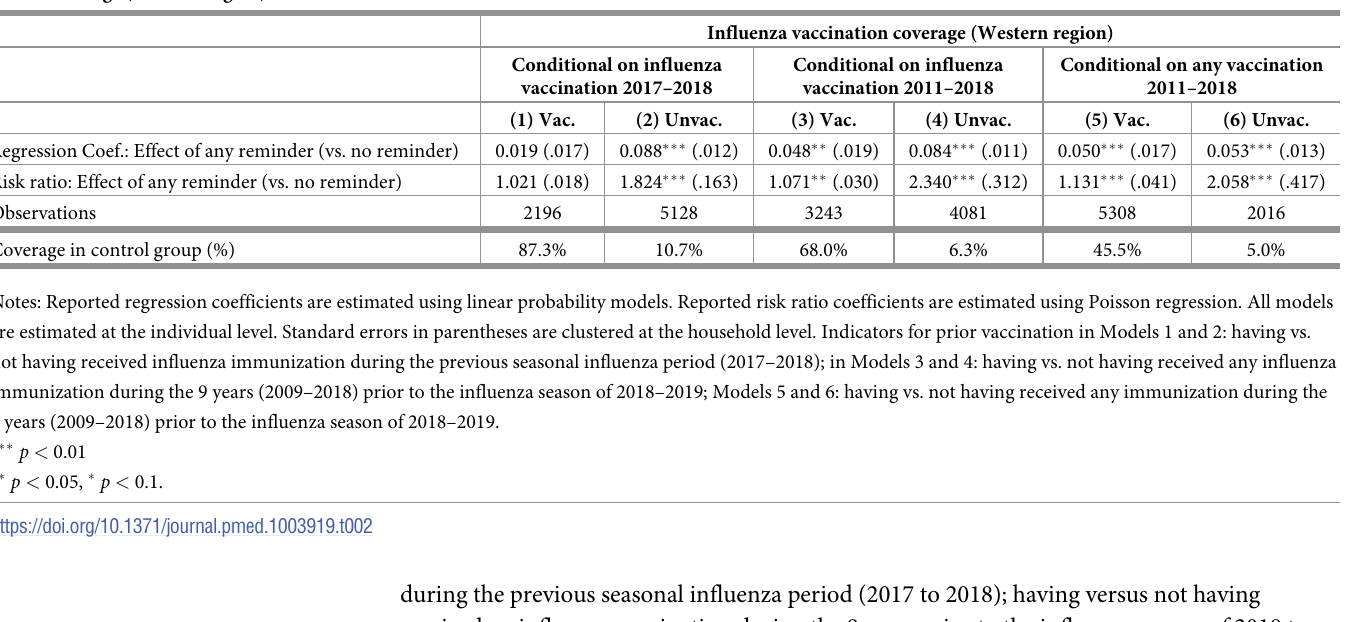
Table 2. The effect of written information letters on influenza vaccination coverage conditional on prior vaccination history in a region with historically low vacci- nation coverage (Western